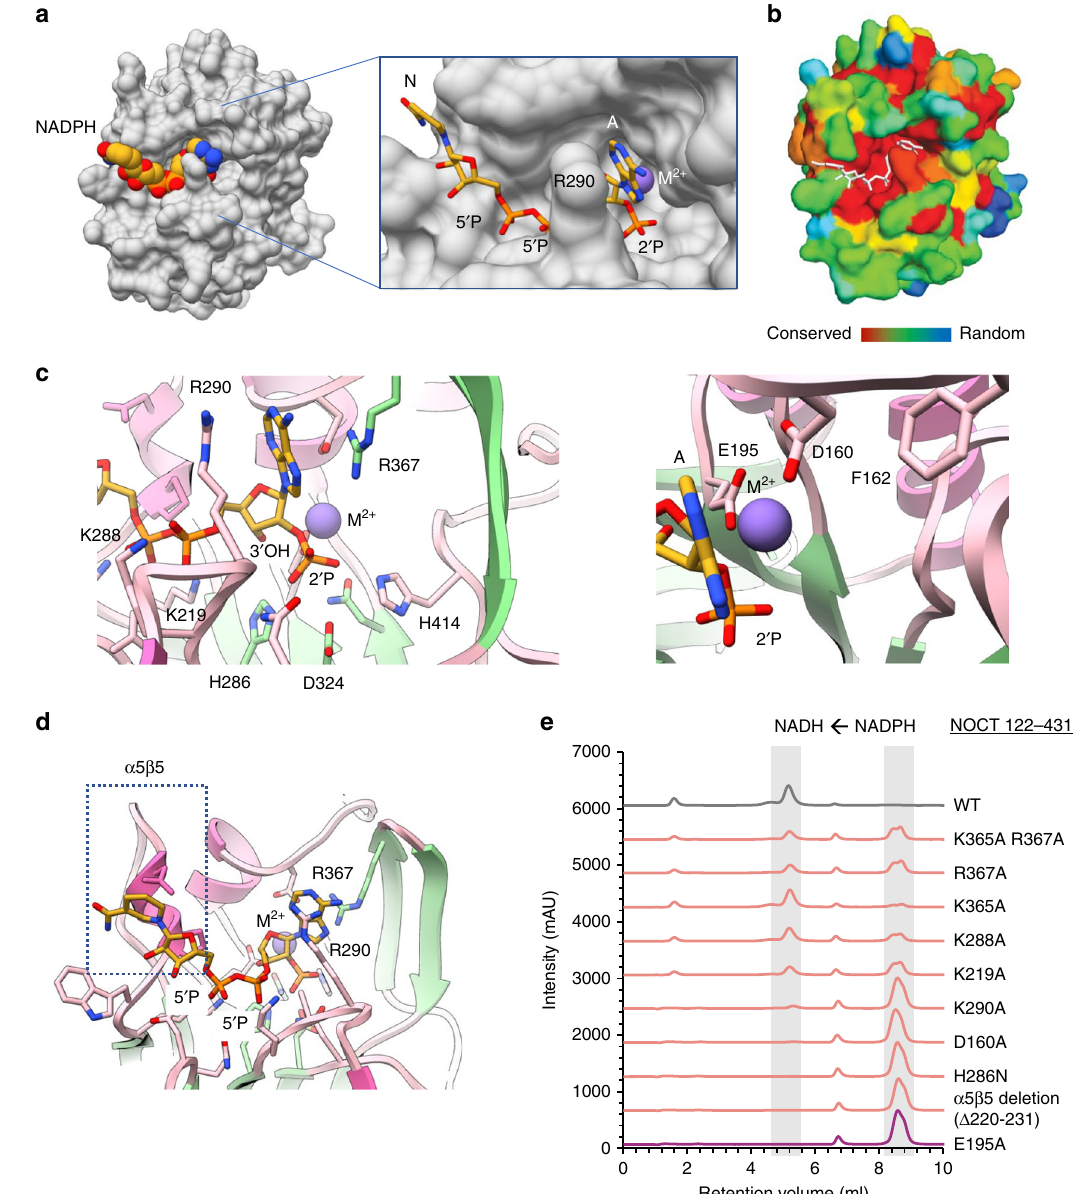
Fig. 4 Structure of human NOCT (cid:129) NADPH (cid:129) Ca 2 + complex. a Surface representation of the complex with NADPH bound to the active site pocket. b NOCT conservation from 351 non-degenerate sequences mapped onto the NOCT structure. Color scale shows a range from invariable (red) to random (blue). c NADPH position and the divalent metal ion coordination in the catalytic center. d NADPH position relative to the α 5 β 5 motif. e NADPH cleavage by NOCT mutants designed to disrupt the enzymatic activity. NOCT catalytic domain (500 nM) and NADPH (0.5 mM) were used. Reactions were conducted at 22 °C for 60